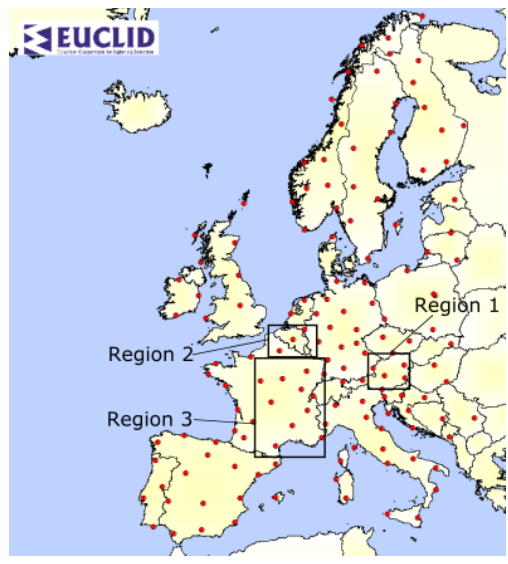
Figure 1. EUCLID network configuration for 2014. Sensor loca- tions are shown as red